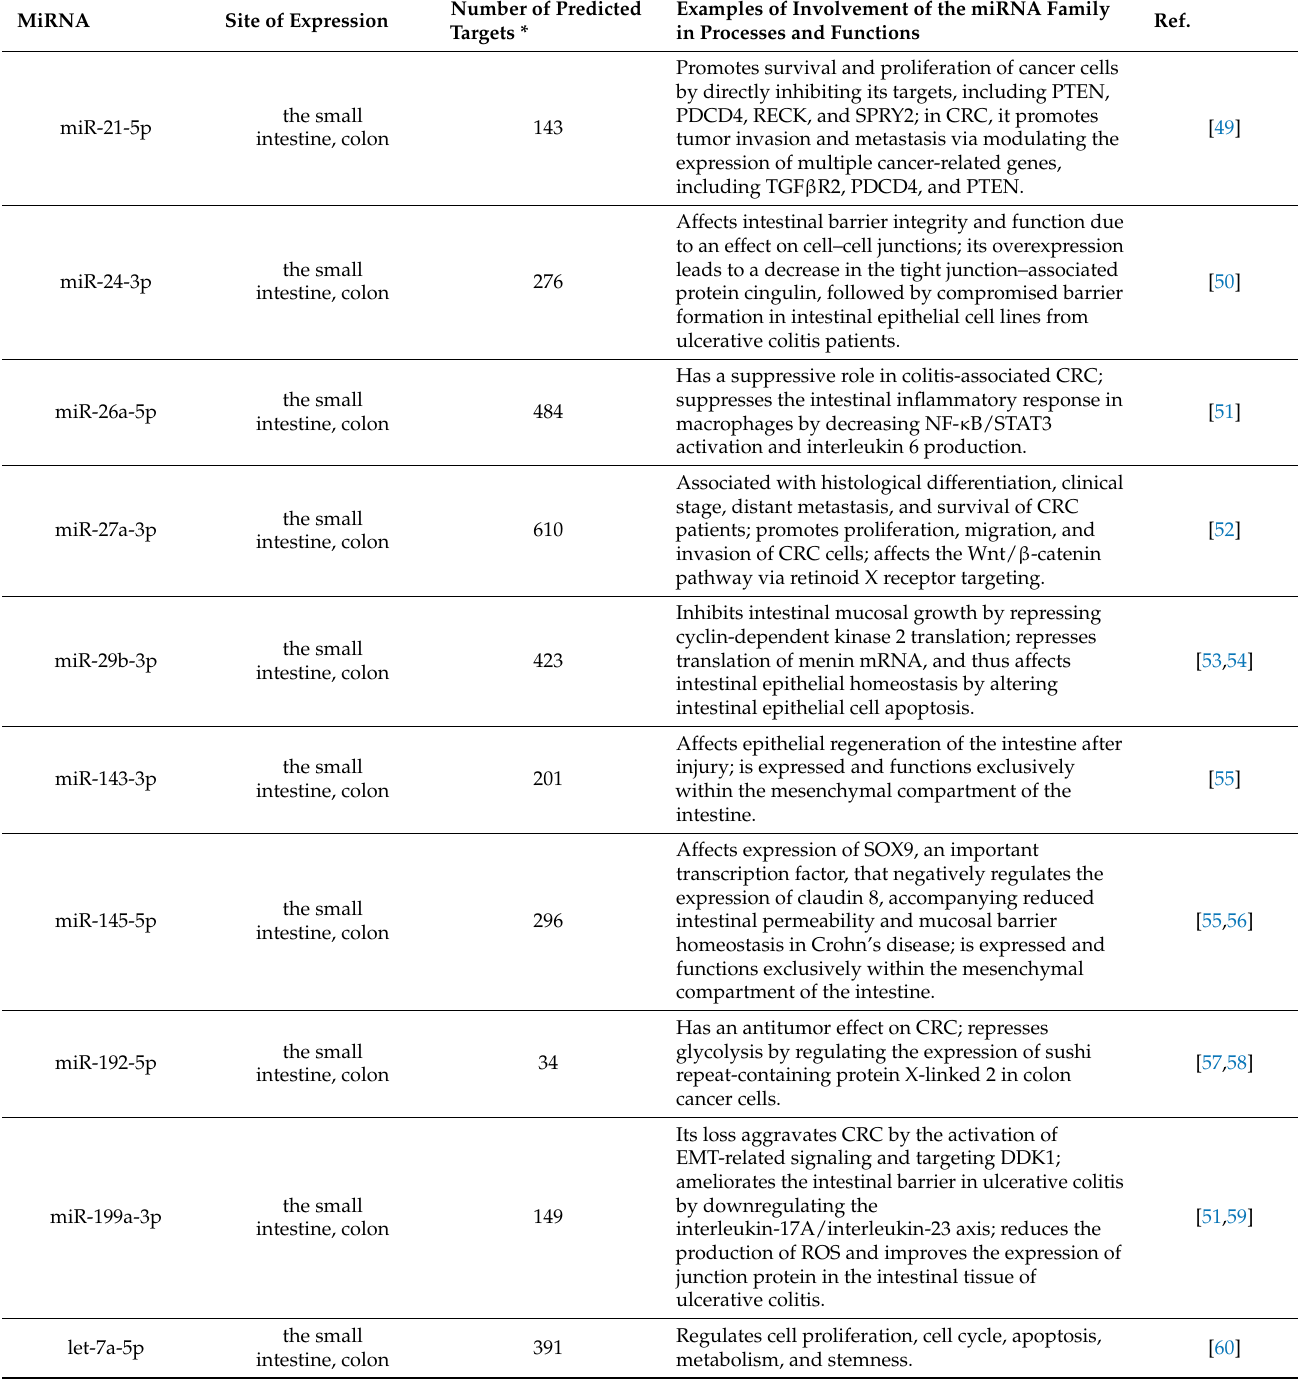
Table 1. An overview of the most abundant miRNAs in the